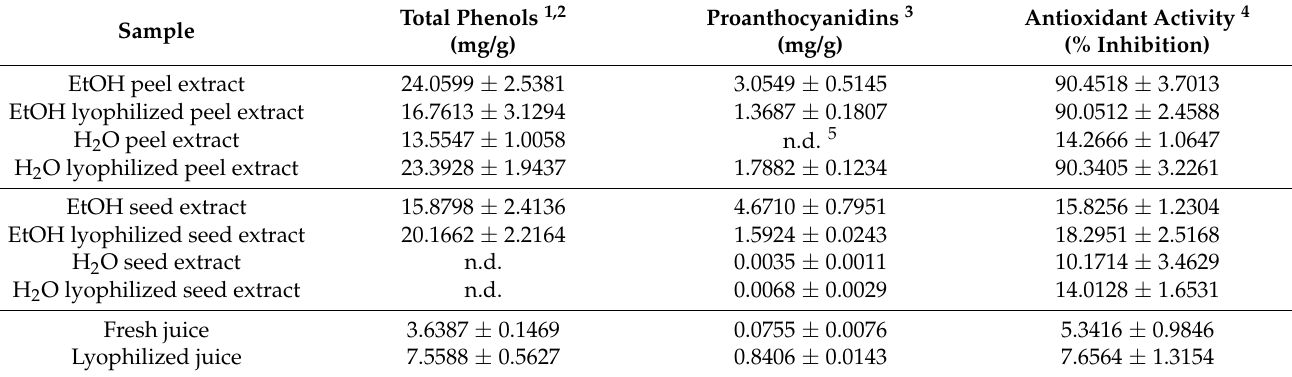
Table 2. Content of phenolics, proanthocyanidins in P. granatum samples and their antioxidative